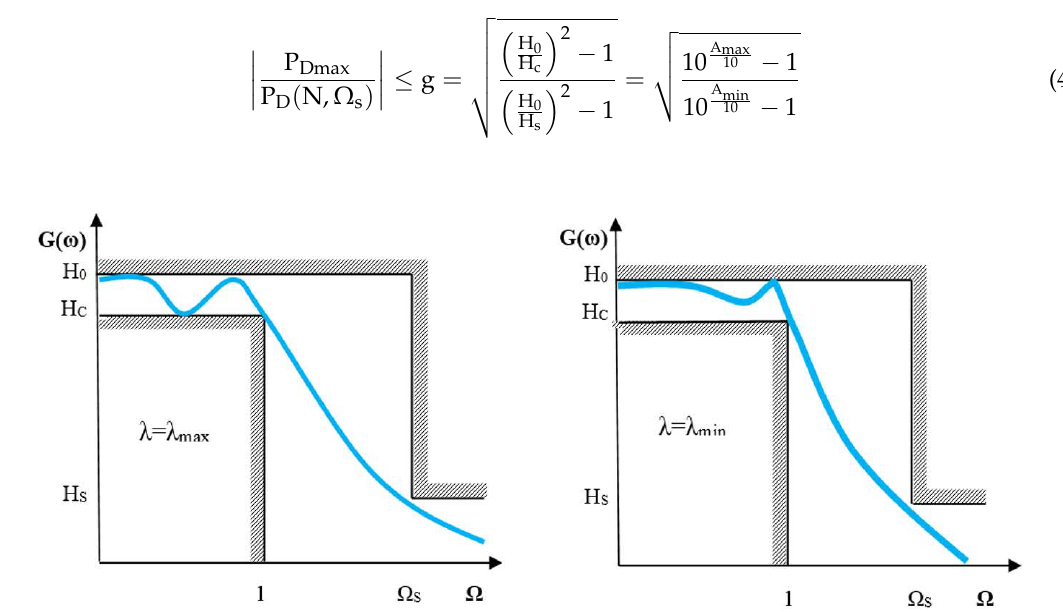
Figure 1. Choices of ripple factor λ , for N Pascal =